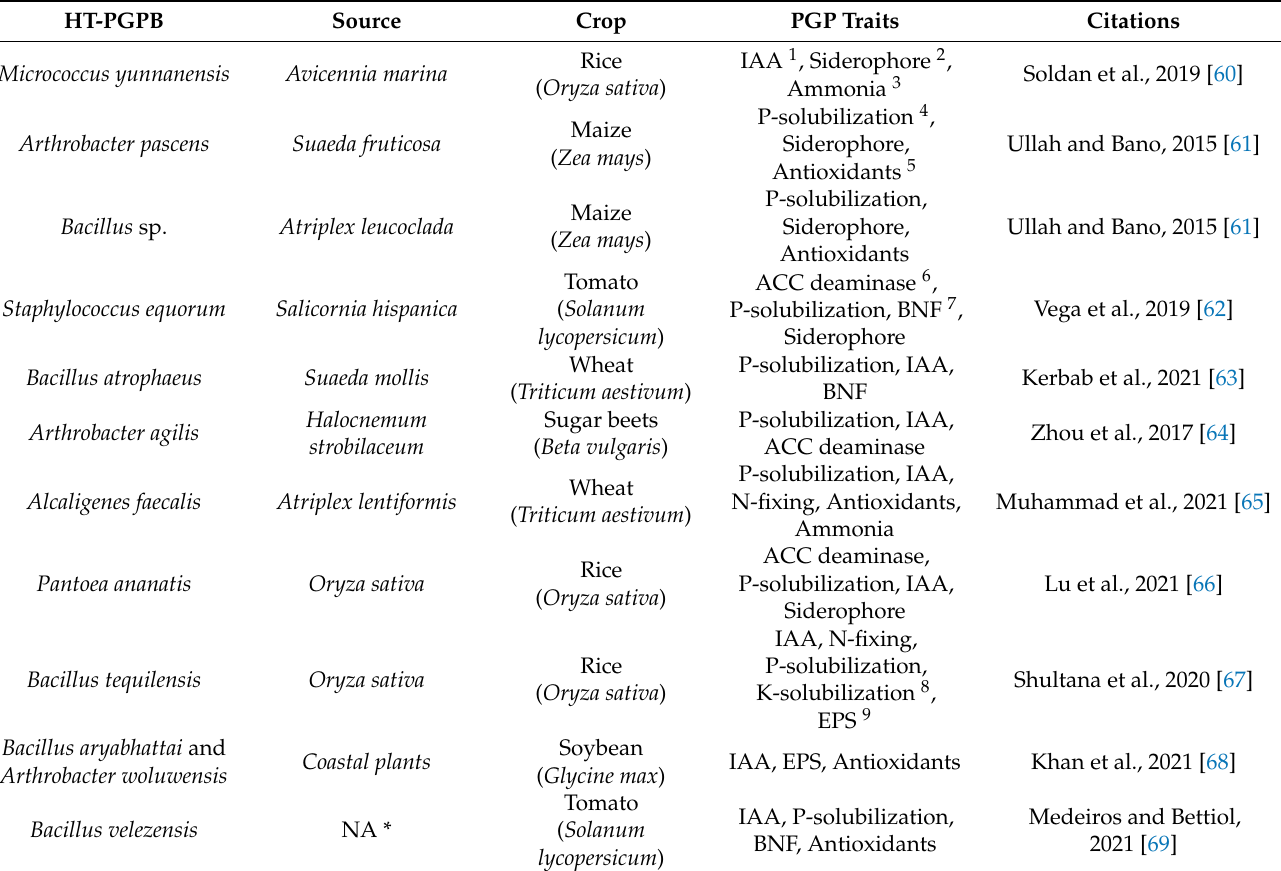
Table 1. The plant growth-promoting (PGP) traits of isolated HT-PGPB with their proven action mechanism on the inoculated